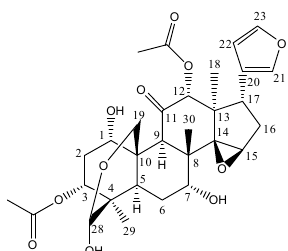
Figure 1. Structure of